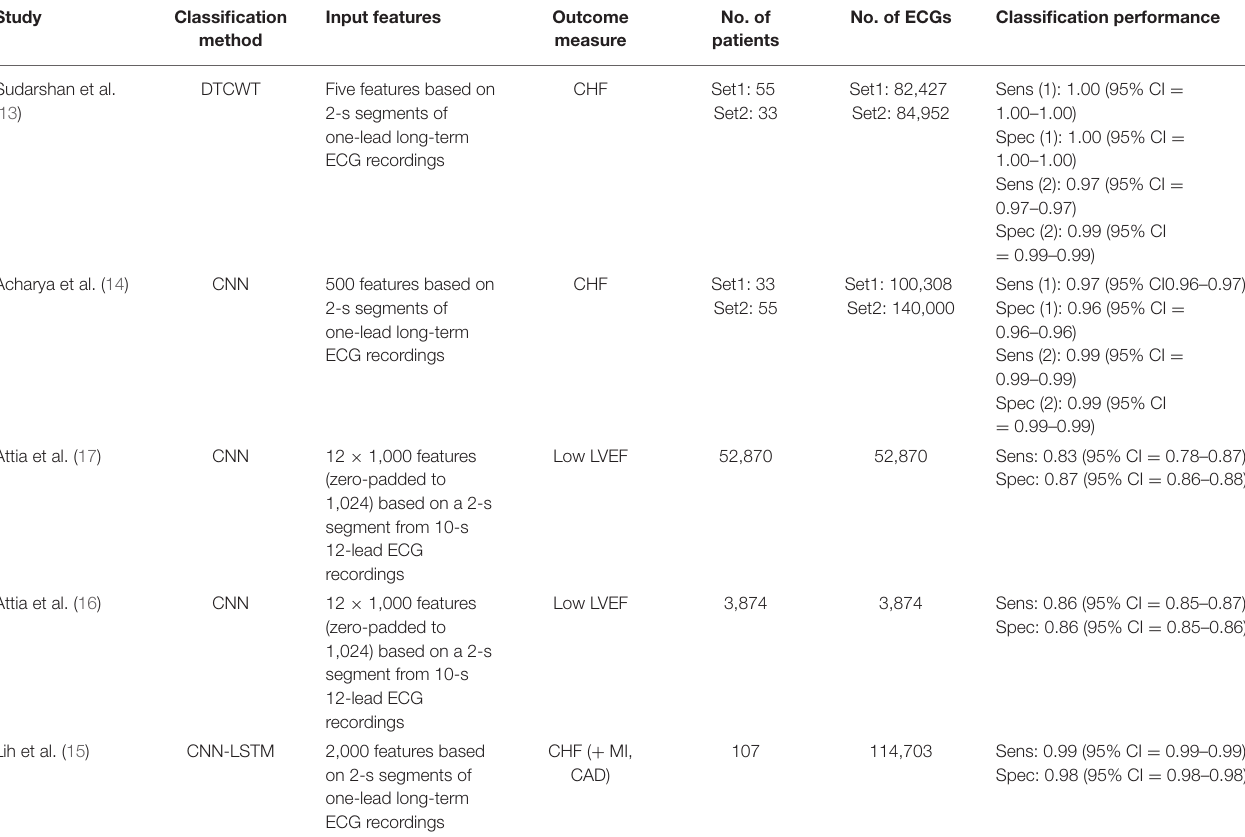
TABLE 1 | Summary of the studies included in the